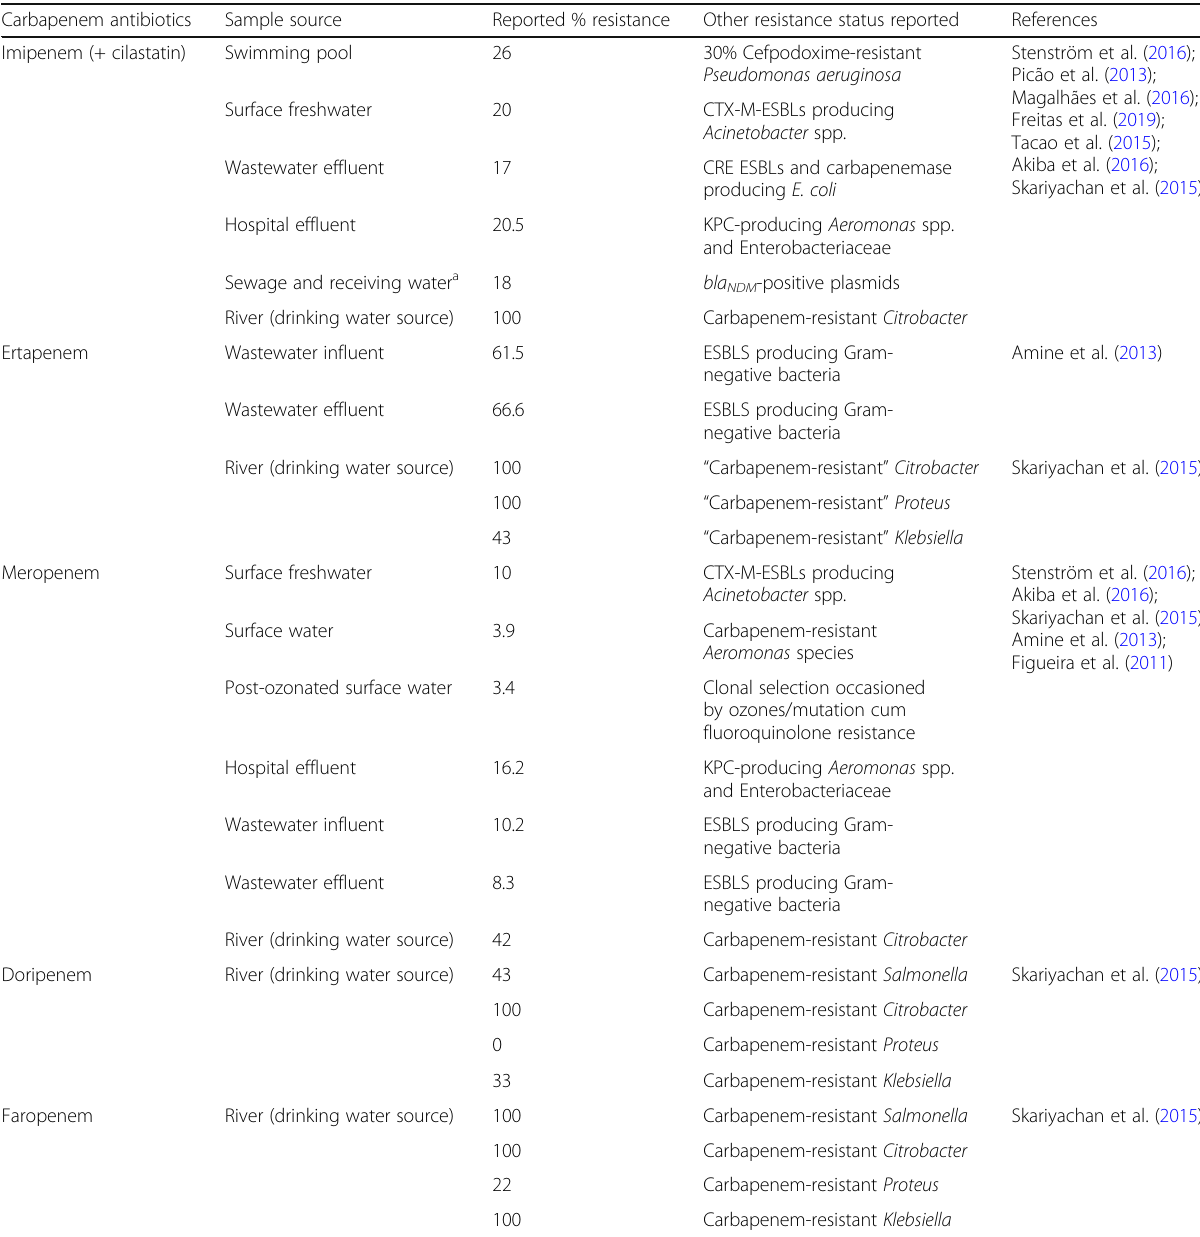
Table 2 Reported antibiotic profile of aquatic Gram-negative bacteria to carbapenem antibiotics in water matrices Carbapenem antibiotics